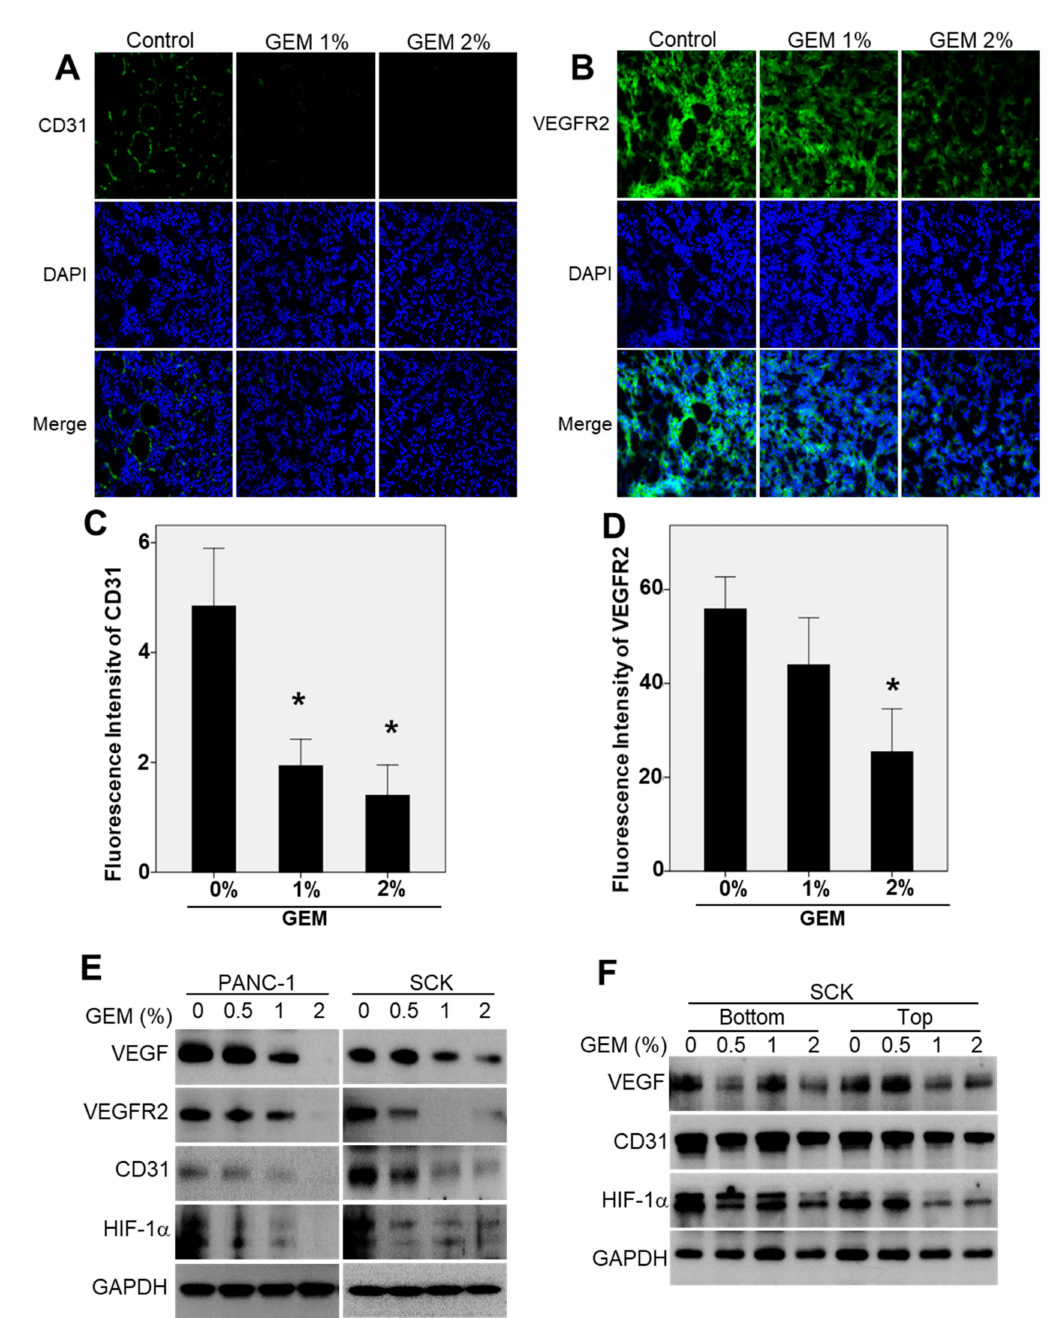
Figure 4. Gemcitabine-eluting membrane (GEM) implantation attenuates angiogenesis in xenograft tumors. Representative results of immunofluorescence analyses of ( A ) CD31 and ( B ) VEGFR2 in SCK tumors implanted with the GEM. Positive protein staining is indicated by green, and nuclei are stained blue with DAPI. Original magnification, × 20. n = 7 fields per group. ( C , D ) The relative fluorescence intensities of CD31 and VEGFR2. ( E ) Western blot analysis of VEGF, VEGFR2, CD31, and HIF-1 α expression in SCK and PANC-1 tumors after implantation with the GEM containing the indicated concentrations of gemcitabine. ( F ) Western blot analysis of VEGF, CD31, and HIF-1 α at the bottom (proximal to the GEM) and top (distal to the GEM) of SCK tumor tissues after GEM implantation. Overall p value was evaluated by ANOVA. * p <